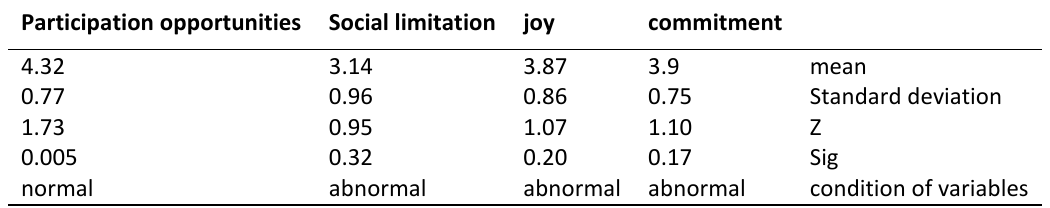
Table 2. Results of Kolmogorov-Smirnov test on sportsmanship commitment and its